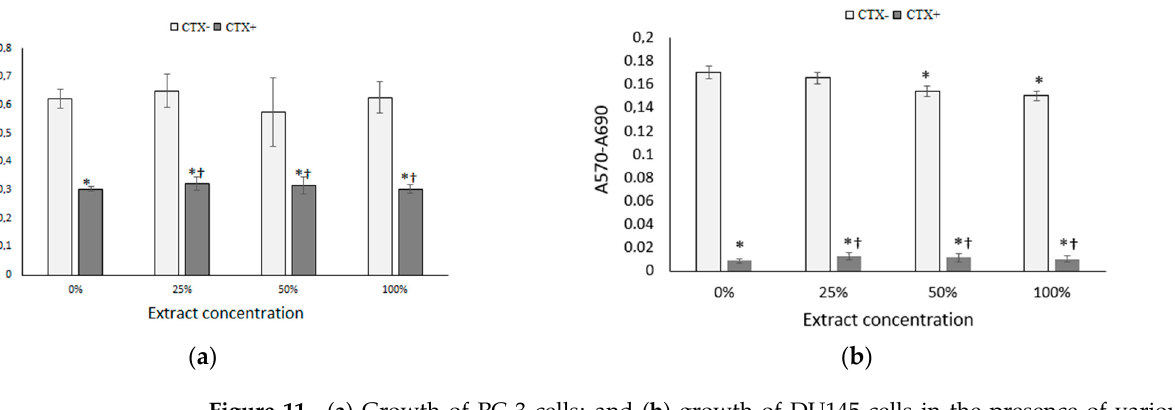
Figure 11. ( a ) Growth of PC-3 cells; and ( b ) growth of DU145 cells in the presence of various concentrations of extracts of nonwovens (indirect contact), assessed using the SRB assay. At the extract concentration of 0%, cells designated as CTX+ were treated with the 10 nM CBT solution; * p <0.05 compared to control; † p <0.05 compared to the empty mat (ANOVA).